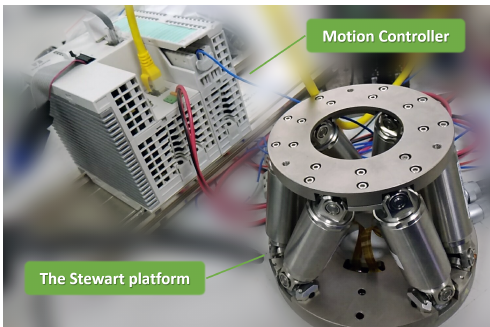
Figure 8. The experiment set-up.